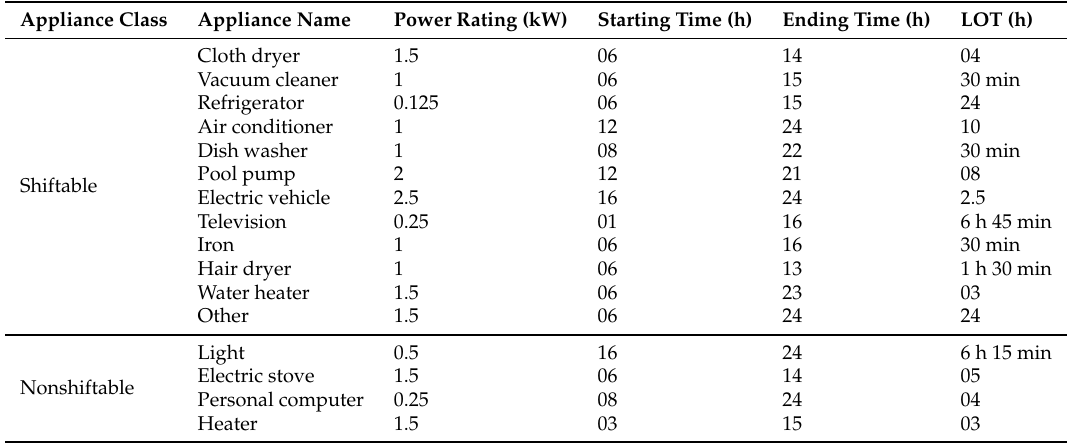
Table 2. Appliances specification details [12]. h: (hours); LOT: Length of operational